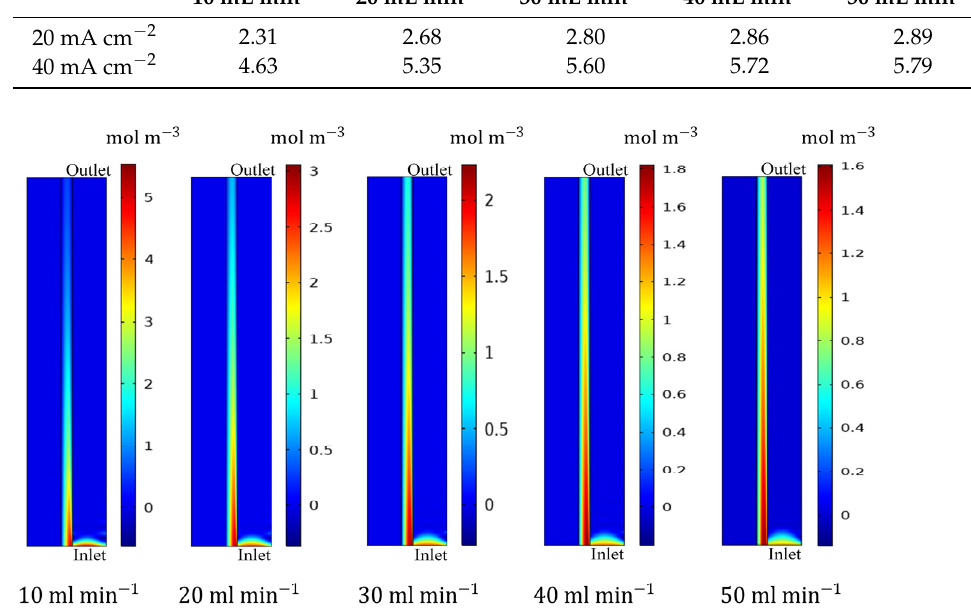
Figure 5. Battery voltage variation with current density at the same flow rate. Table 4. Discharge capacities of battery with different positive electrolyte flow rates at different current densities (Ah). 20 mA cm (cid:2879)(cid:2870)